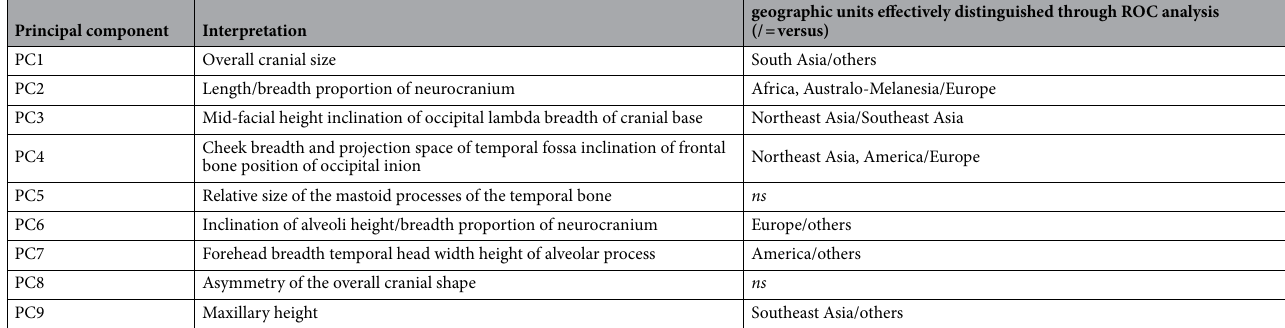
Table 3. Interpretations of distinguishable components in PCA between homologous cranial models by geographical units. ns no significant.